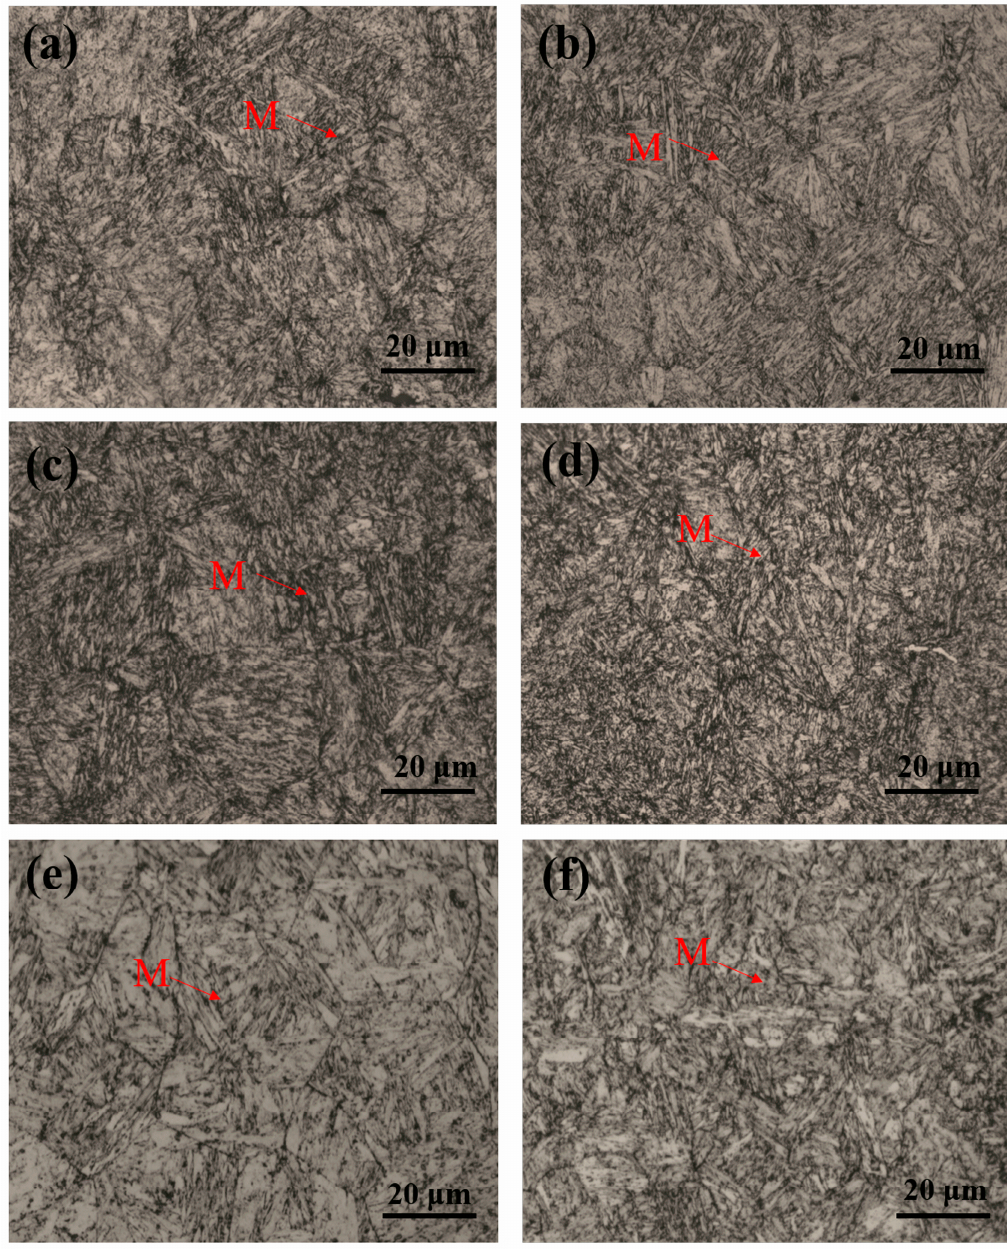
Figure 3. Metallographic images of tested steel after tempering: ( a ) Nitrogen-free steel (600 ◦ C for 2 h); ( b ) nitrogen-alloyed steel (600 ◦ C for 2 h); ( c ) nitrogen-free steel (600 ◦ C for 4 h); ( d ) nitrogen-alloyed steel (600 ◦ C for 4 h); ( e ) nitrogen-free steel (650 ◦ C for 4 h); ( f ) nitrogen-alloyed steel (650 ◦ C for 4 h).